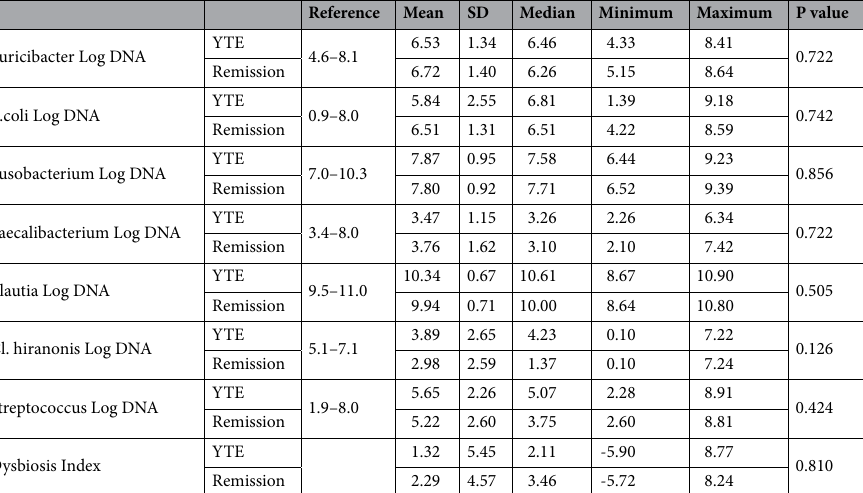
Table 5. Summary statistics of the abundances of bacterial groups assessed for the DI in YTE before and after treatment. DI, dysbiosis index; YTE, Yorkshire Terrier enteropathy; SD, standard